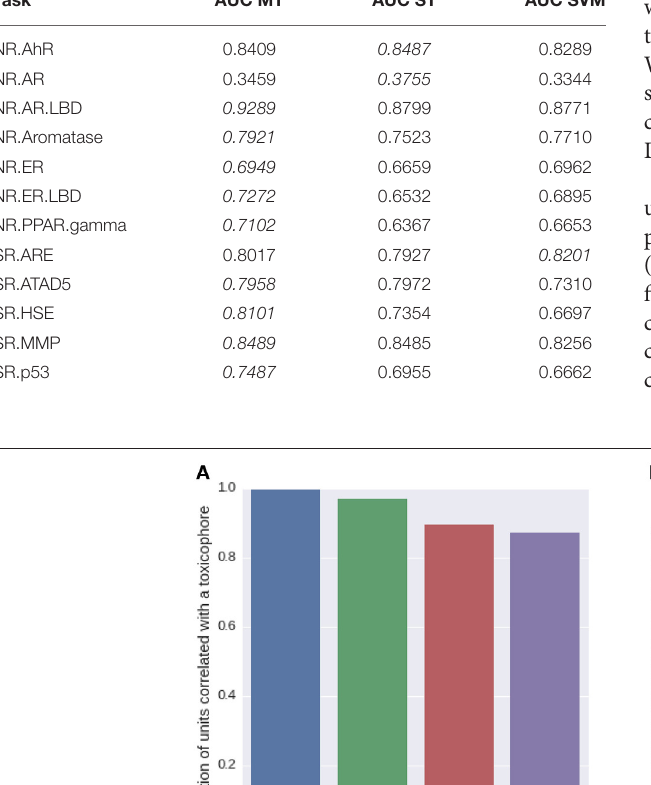
TABLE 3 | Comparison: multi-task (MT) with single-task (ST) learning and SVM baseline evaluated on the leaderboard-set. Task